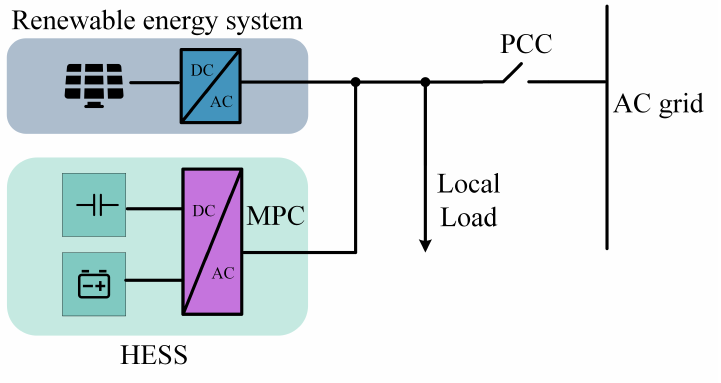
Figure 1. Circuit configurations for renewable energy system with HESS.